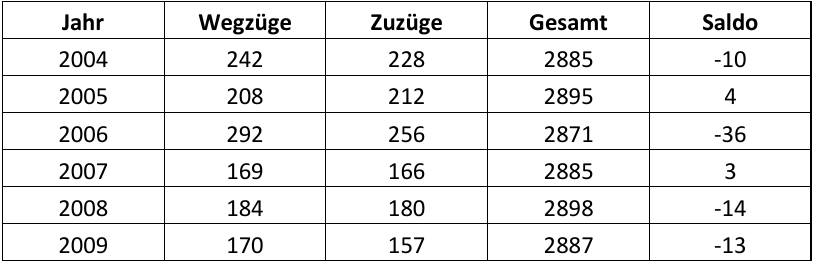
der Gemeinde Frasdorf) Table 3: Emigration in Frasdorf between 2004 and 2009 (source: written notification of the municipality